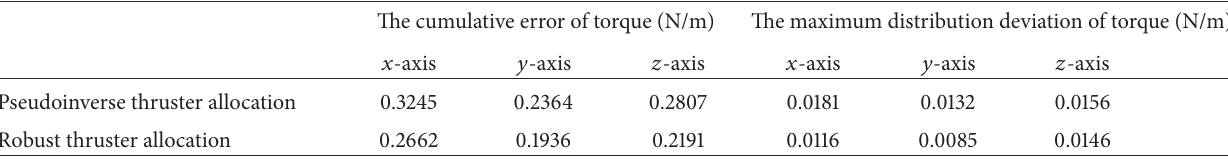
Table 1: The simulation result when the control efficiency matrix is with the uncertainty of